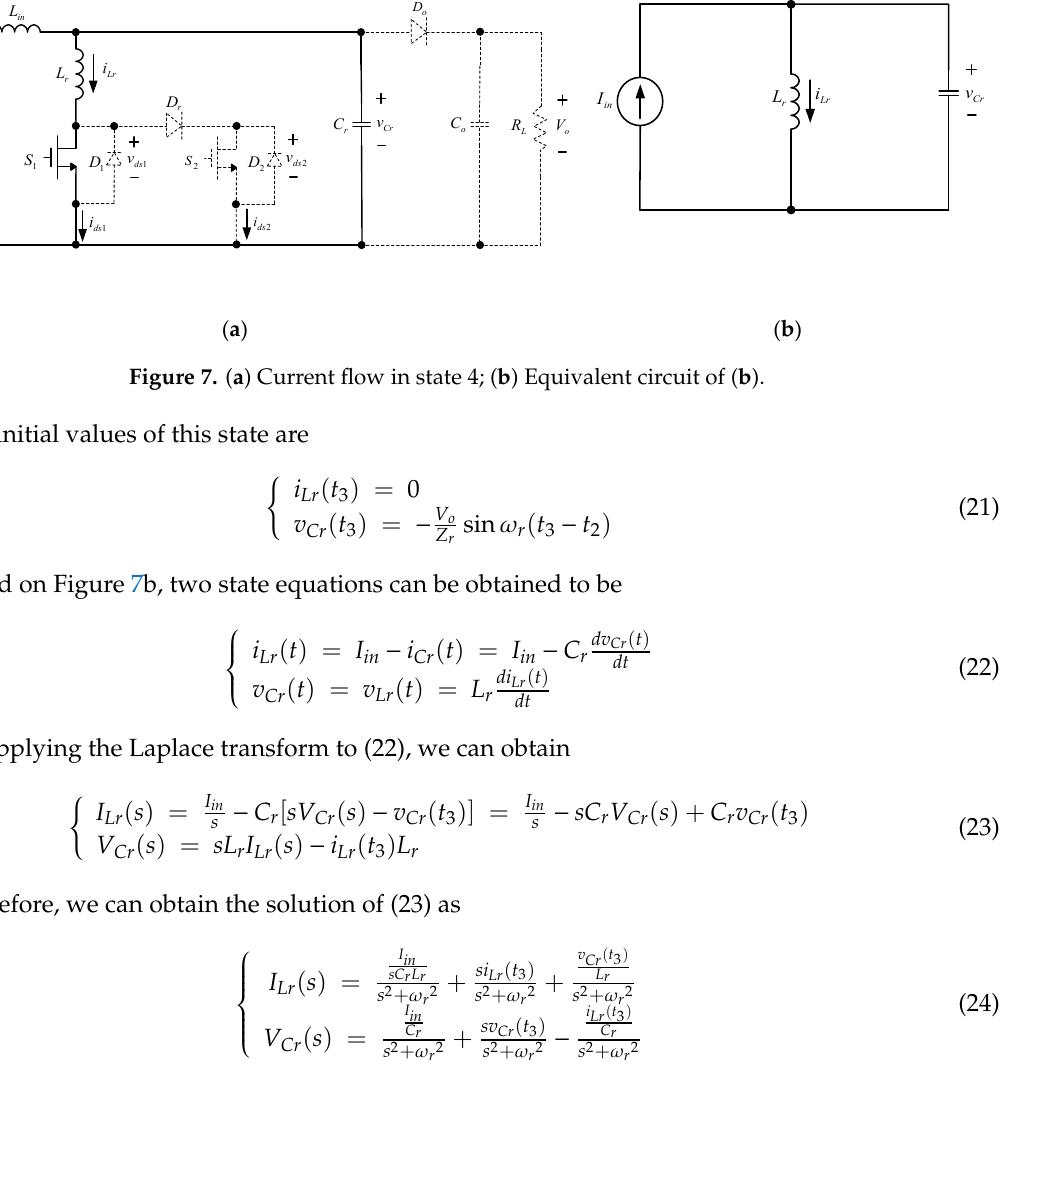
( b ) Figure 8. ( a ) Current flow in state 5; ( b ) Equivalent circuit of ( a ).